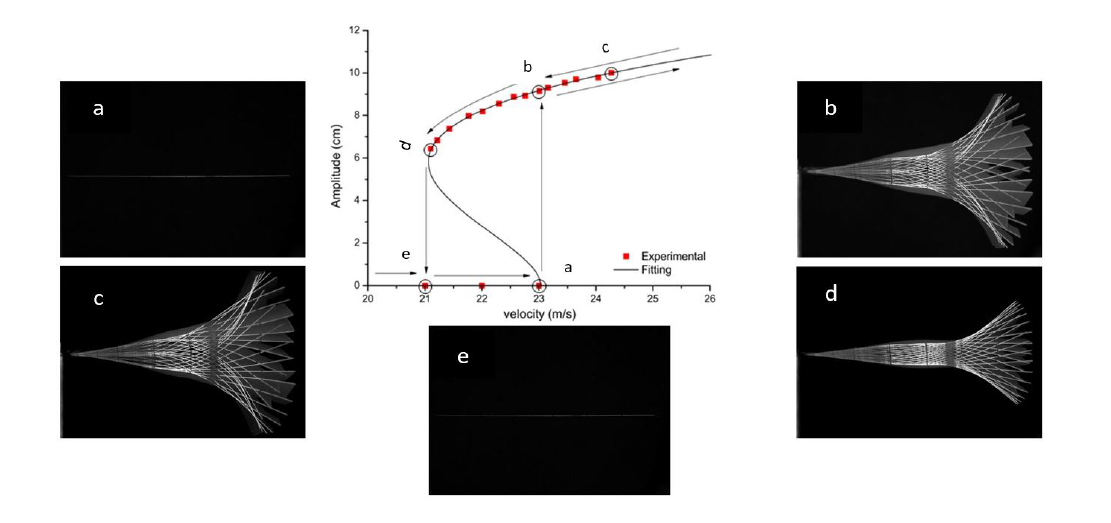
Figure 10. Bifurcation diagram for Al patched flag.